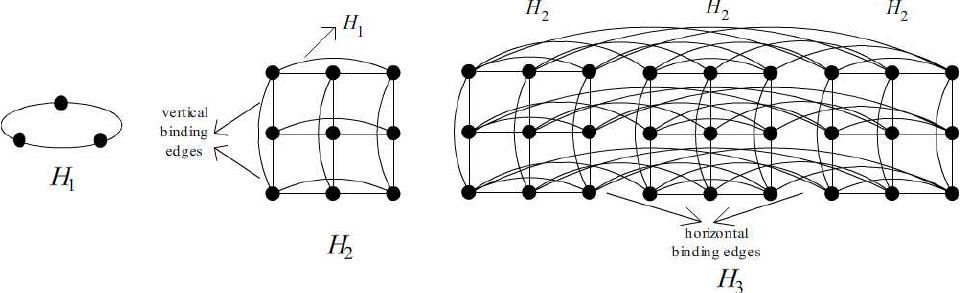
Figure 1. Structure of H 1 , H 2 and H 3